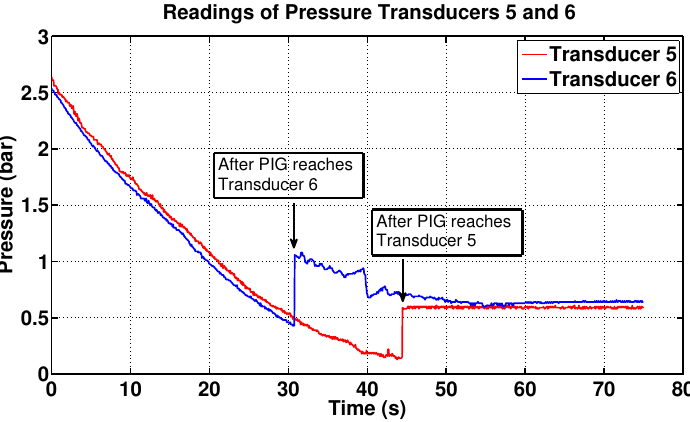
Figure 13. Supervisory data of PIG’s passage between the transducers 6 and 5. Source: By authors. Based on the memory card data, it was verified that the PIG travelled 5.70 m in 12.53 s, resulting in an average speed of 0.45 m/s (Figure 14). The speed value delivered by the odometer is more reliable because it is a direct reading, while the value delivered by supervisory is indirect, a estimative.